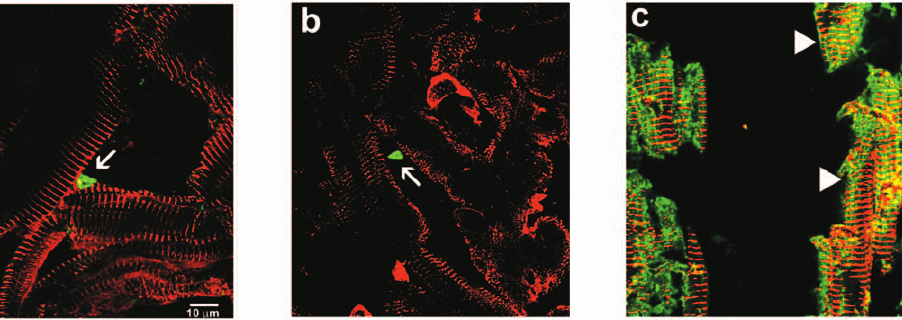
Figure 9. High-magnification confocal co-immunofluorescent staining for Pnmt and sarcomeric a -actinin in adult mouse heart (LV) sections. Pnmt immunofluorescent staining in the adult mouse heart identifies small triangular-shaped cells (green) (a, b arrows) within the interstitial spaces. Cardiomyocyte-specific staining for sarcomeric a -actinin (red) shows identifiable striations in branching cells. Immunofluorescent co-staining with Pmnt and sarcomeric a -actinin shows apparent Pmnt expression within some cardiomyocytes (c, arrowheads).